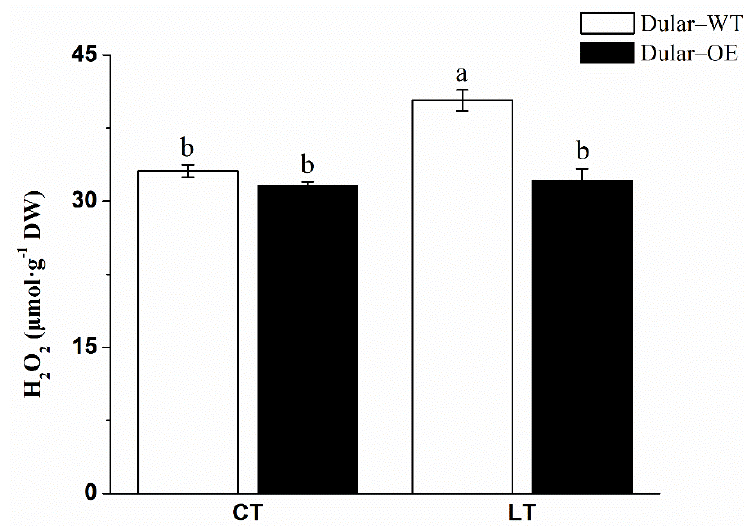
Figure 4. The H 2 O 2 content in rice leaves. Columns with different letters are significantly different (LSD test, p < 0.05). Error bars are the standard error (±SE) of three biological replications. DW: dry weight; CT: normal temperature; LT: low temperature.